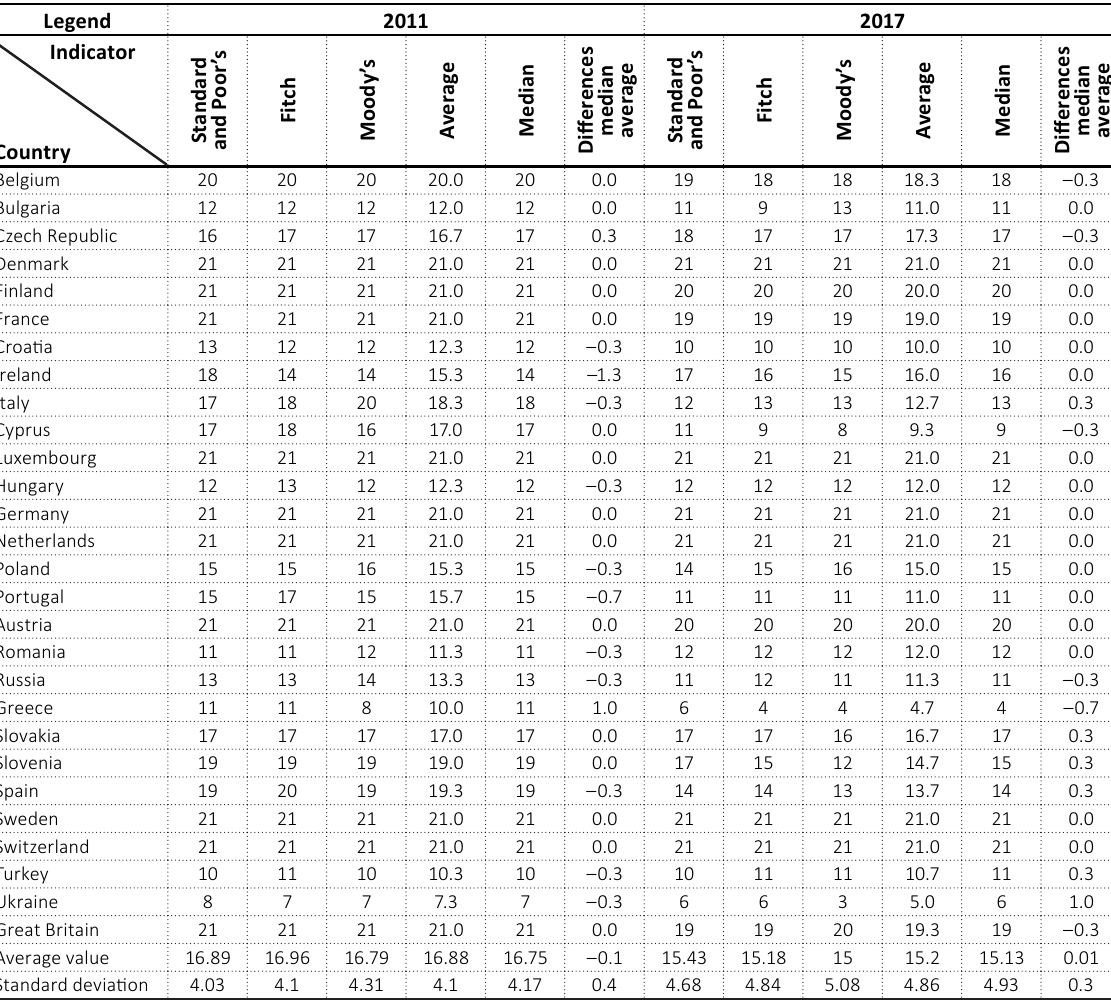
Table 2. Comparison of arithmetic means and median when aggregating credit rating marks